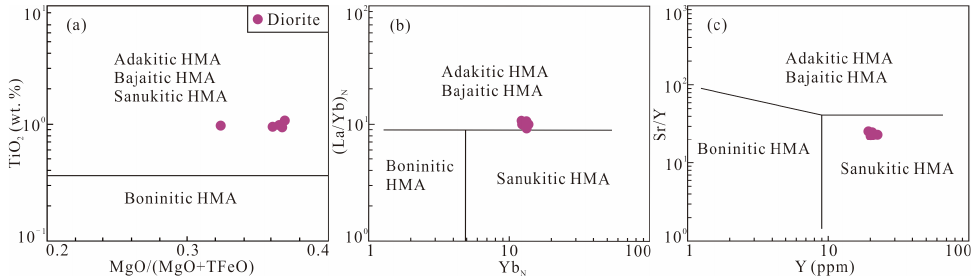
Figure 15. Diagrams of ( a ) MgO/(MgO+TFeO) versus TiO 2 (modified after [109]), ( b ) Yb N versus (La/Yb) N (modified after [112]) and ( c ) Y versus Sr/Y (modified after [114]) of the diorites, showing the classification of sanukitic HMA.